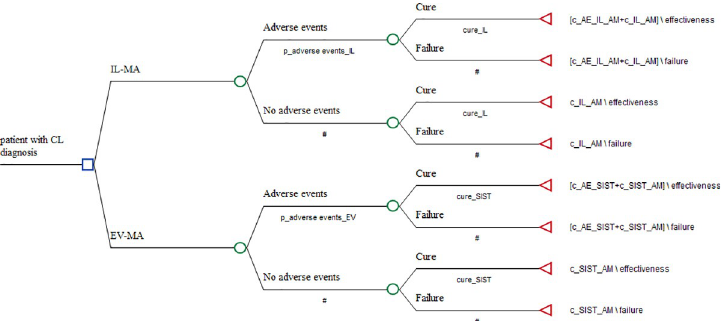
Fig 1. Simplified decision tree model for the analyses of the cost-effectiveness of intralesional infiltration, in comparison with parenteral use of meglumine antimoniate, in the treatment of cutaneous leishmaniasis. IL-MA: meglumine antimoniate intralesional infiltration; EV-MA: endovenous meglumine antimoniate therapy; p_adverse eventes_IL: probability of adverse events during IL-MA; p_adverse eventes_EV: probability of adverse events during during EV-MA; cure_SIST: cure rate for endovenous meglumine antimoniate therapy; cure_IL: cure rate for meglumine antimoniate intralesional infiltration; c_IL_AM: total cost for meglumine antimoniate intralesional infiltration; c_SIST_AM: total cost for endovenous meglumine antimoniate therapy; c_AE_IL_AM: total cost related to adverse events during IL-MA; c_AE_SIST: total cost related to adverse events during